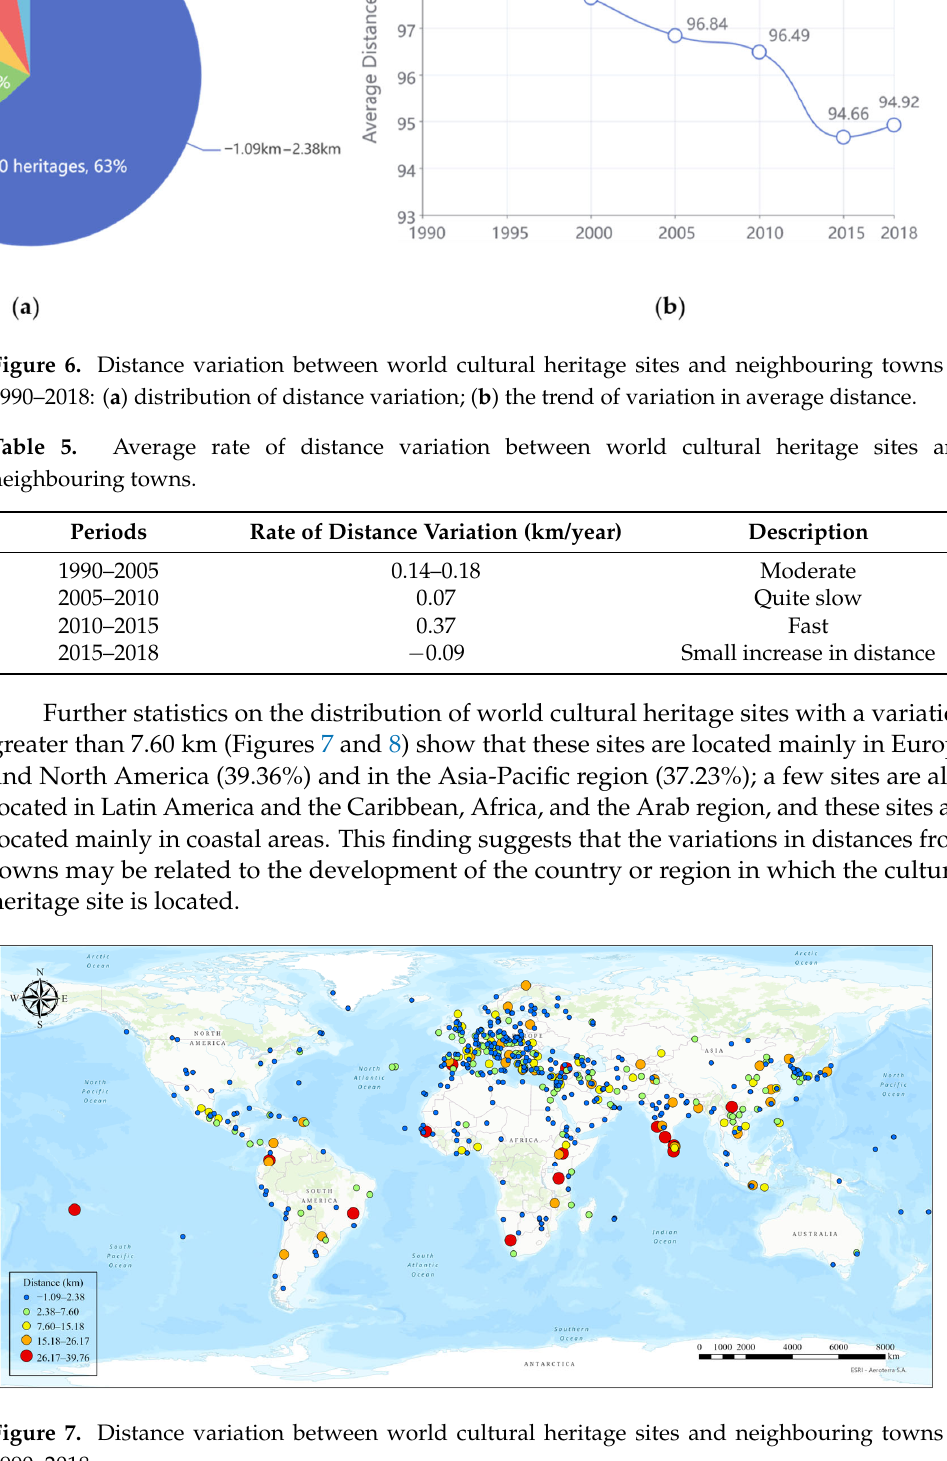
Figure 8. Distribution of world cultural heritage sites with a variation in distance greater than 7.60 km from neighbouring towns in 1990–2018.